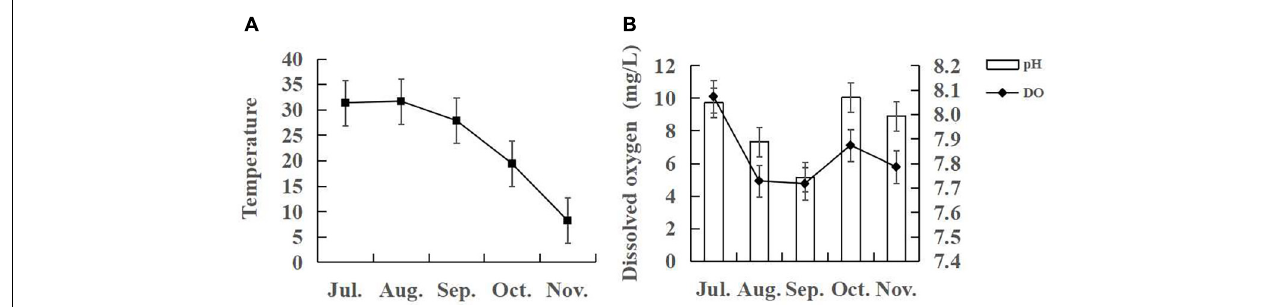
FIGURE 1 | Trends in (A) temperature and (B) dissolved oxygen and pH in pond water used to culture juvenile E. sinensis from July to November, 2018.